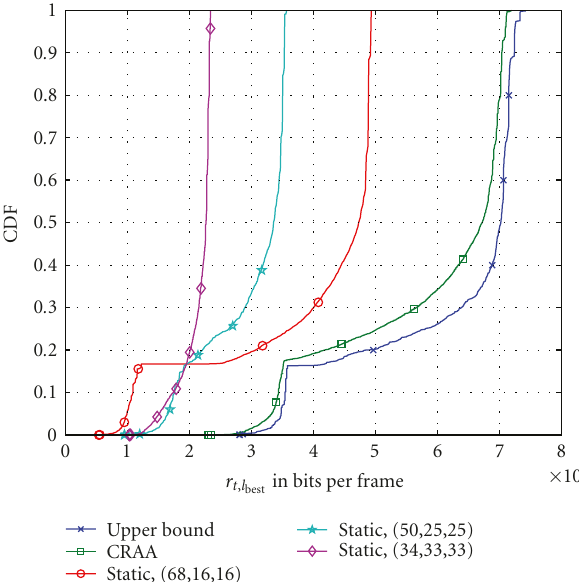
Figure 7: Average sum rate of resource allocation algorithms depending on the number of SSs. The minimum data rate is 640 bits per frame.